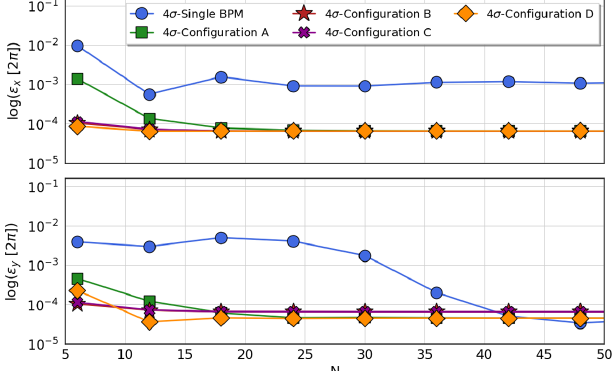
FIG. 13. Comparison of the accuracy for the tune measure- ments with single-BPM (blue curve) and mixed BPM configu- rations for configuration A (green curve), configuration B (red curve), configuration C (purple curve), and configuration D (orange curve). The excitation corresponds to 4 σ for the hori- zontal (top) and vertical (bottom) tunes.